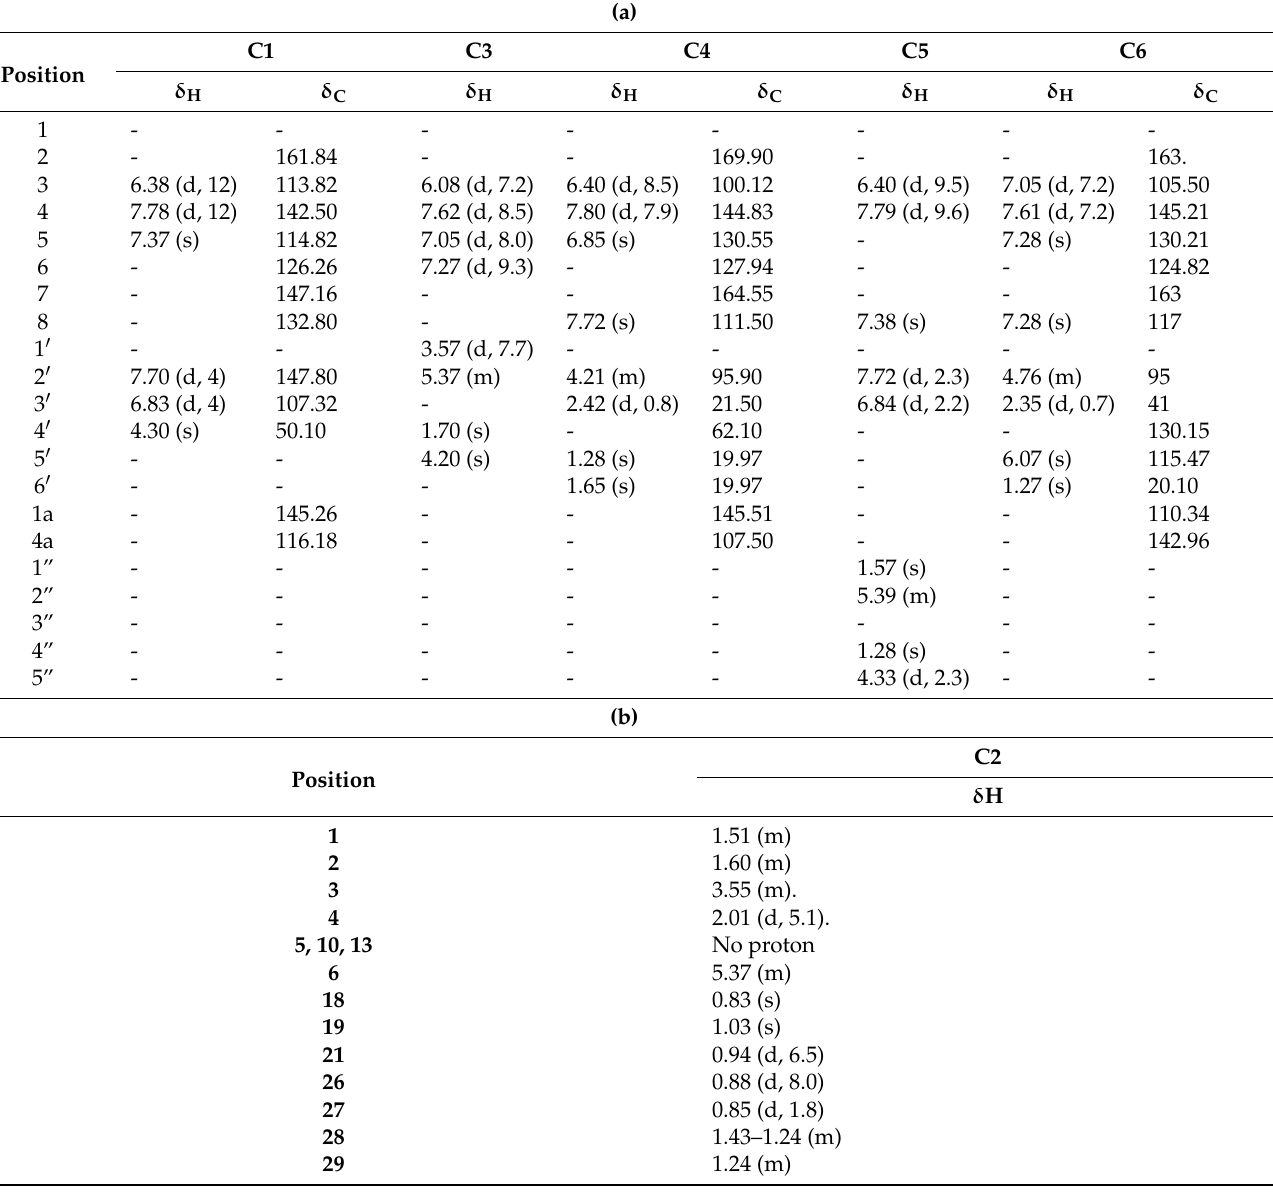
Table 1. ( a ) 1 H-NMR and 13 C-NMR/APT-NMR of coumarin compounds isolated from A. majus